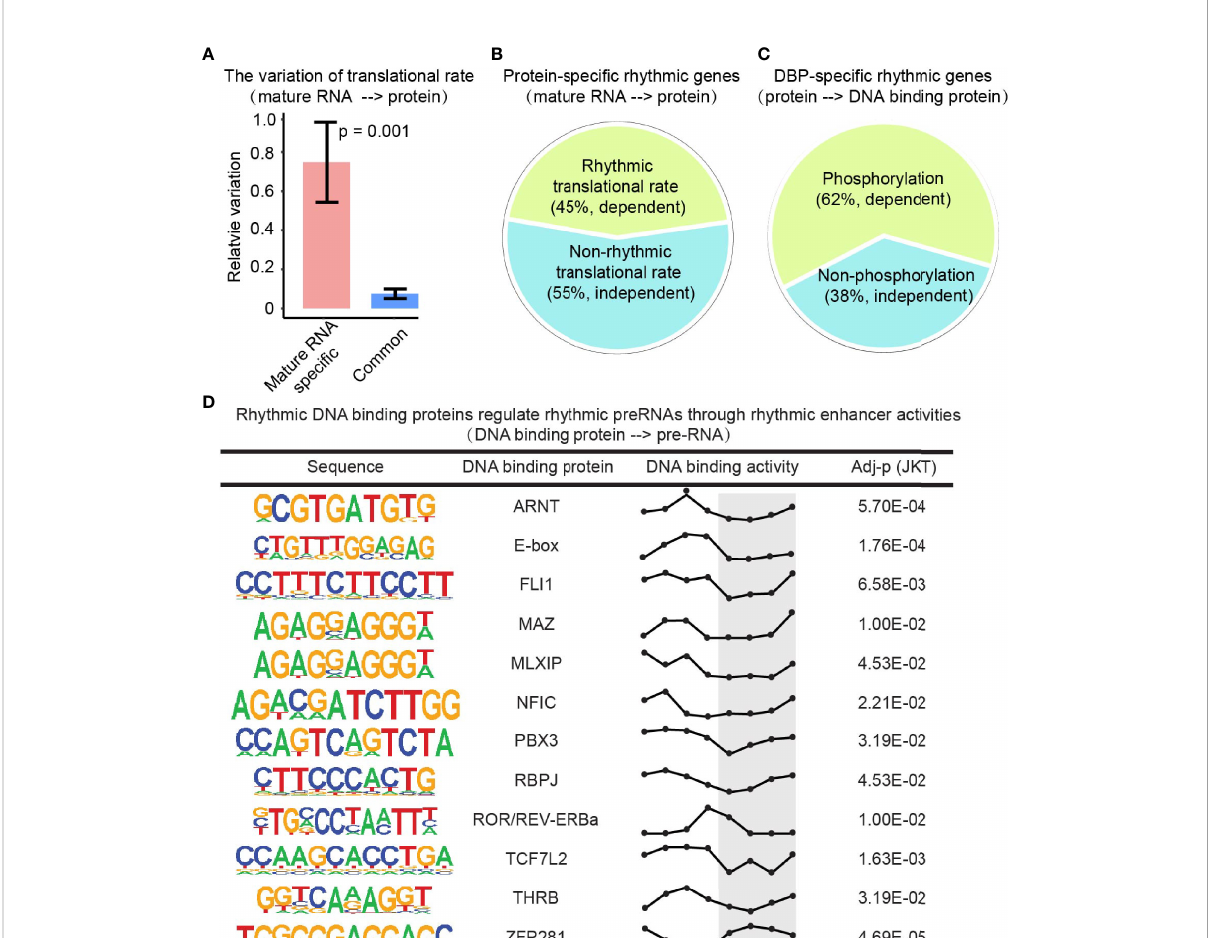
FIGURE 5 Translation rate, post-translational modi fi cation, and epigenetic effect contribute to the layer-speci fi c diurnal rhythm. (A) Bar plot shows the variation of translation rates of mature RNA-speci fi c rhythmic genes and the conserved rhythmic genes. P value comes from Student ’ s t-test. (B) Protein-speci fi c rhythmic genes with rhythmic (olive green) or non-rhythmic (cadet blue) translational rate. (C) DBP-speci fi c rhythmic genes that were phosphorylated (olive green) or not (cadet blue). (D) The DBPs with rhythmic activities regulate rhythmic transcription through rhythmic enhancer activities. The Y axis in the third column present the DNA binding activities. And the X axis present the Zeitgeber time (ZT), a standardized 24-hour notation of the phase in an entrained circadian cycle. ZT0 is the time that light is turned on and ZT12 is the time that light is turned